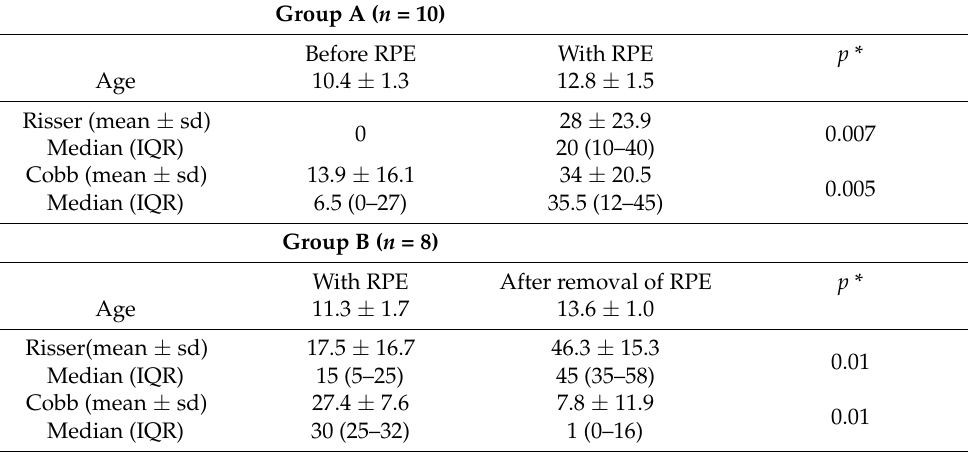
Table 2. Mean ± standard deviation of age, Risser value, Cobb angle and median (IQR) of Group A and B. and B.